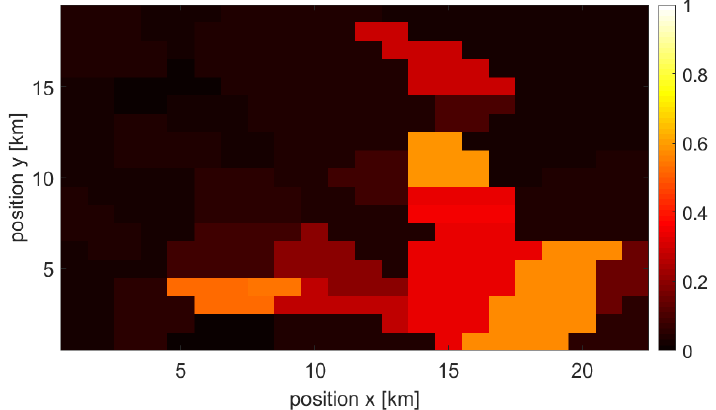
Figure 3. Example of a user density map created by camera data.